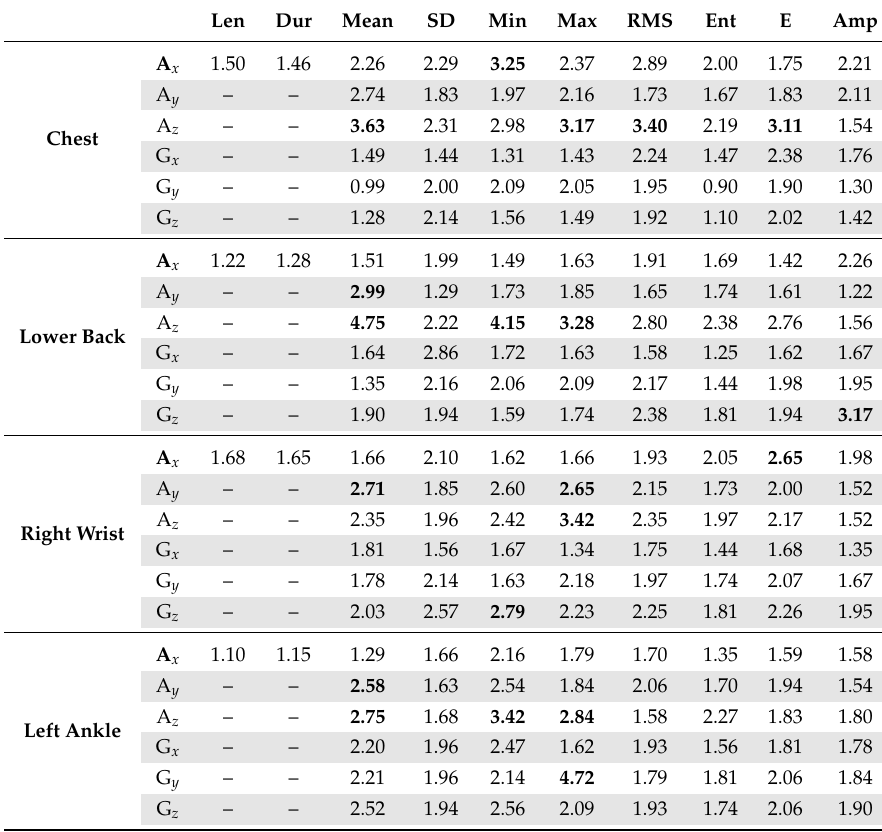
Table 9. Features’ importance computed during age classification using the 10-fold cross-validation strategy. The top 5 contributing features are highlighted with bold text. All values are the